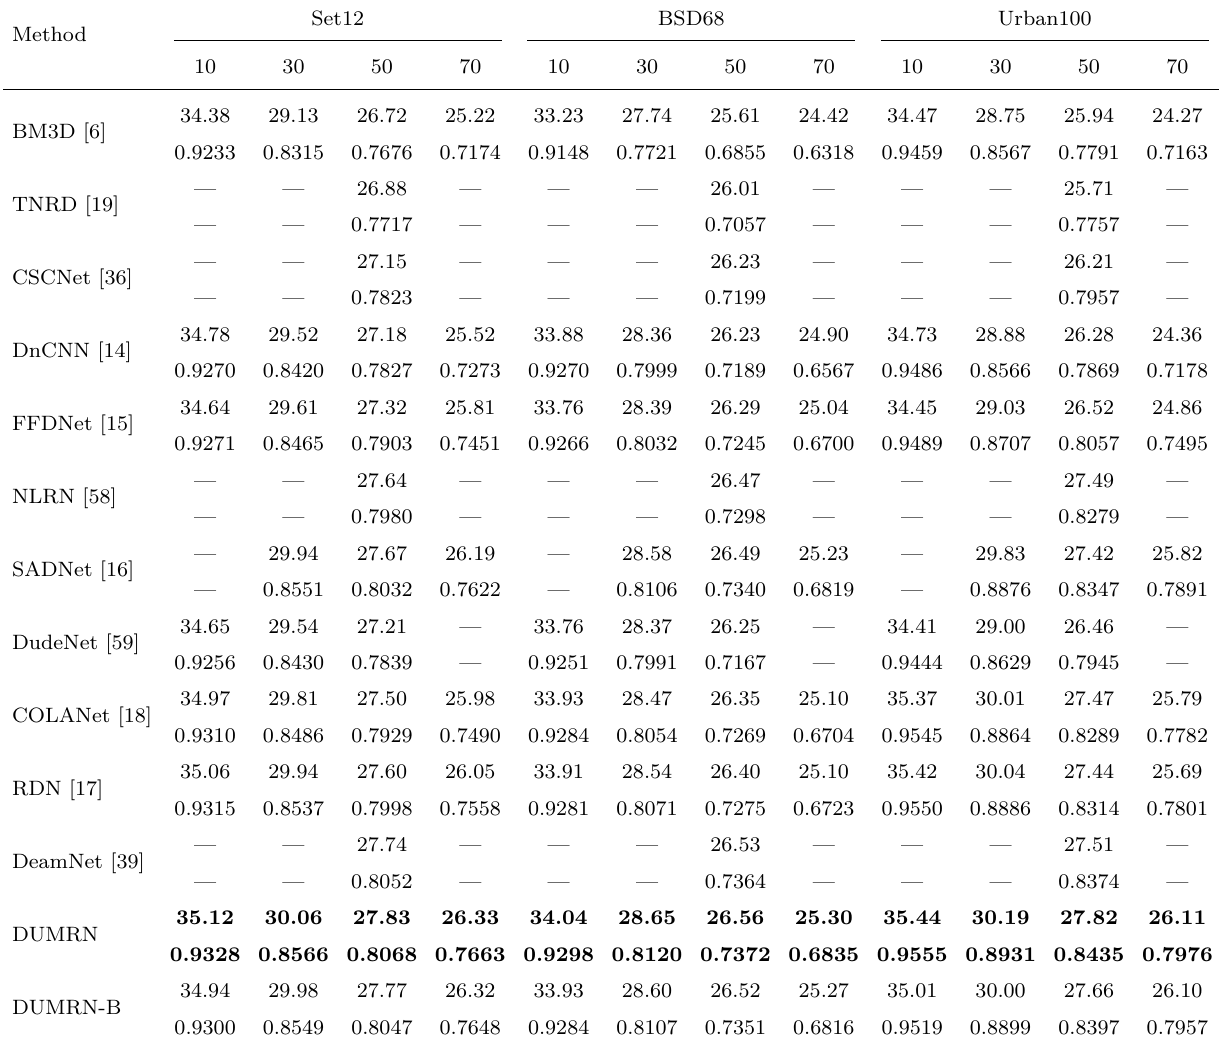
Table 1 Average PSNR (dB) and SSIM results for different methods on the gray-scale datasets for noise levels σ =10, 30, 50, and 70. Best results are highlighted in bold. “—” means that a result is unavailable